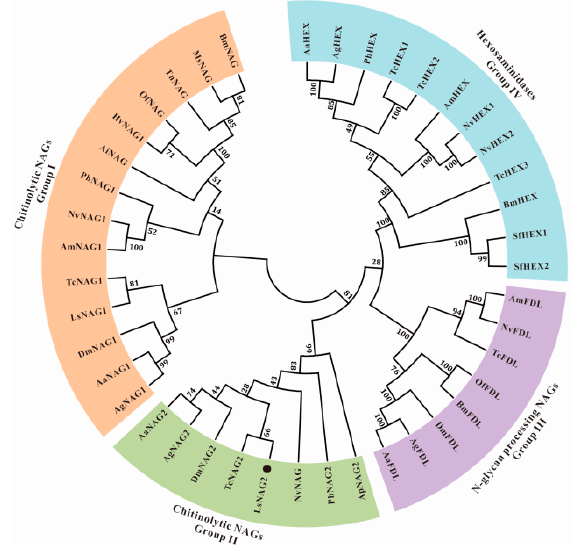
Figure 2. Phylogenetic analysis of insect β - N -acetylglucosaminidases. The phylogenetic tree was constructed using neighbor-joining method and bootstrap support values on 1000 replicates by MEGA7. LsNAG2 is marked with black dots. Table S2 shows the protein sequences of the β - N -acetylglucosaminidases used in the phylogenetic tree.